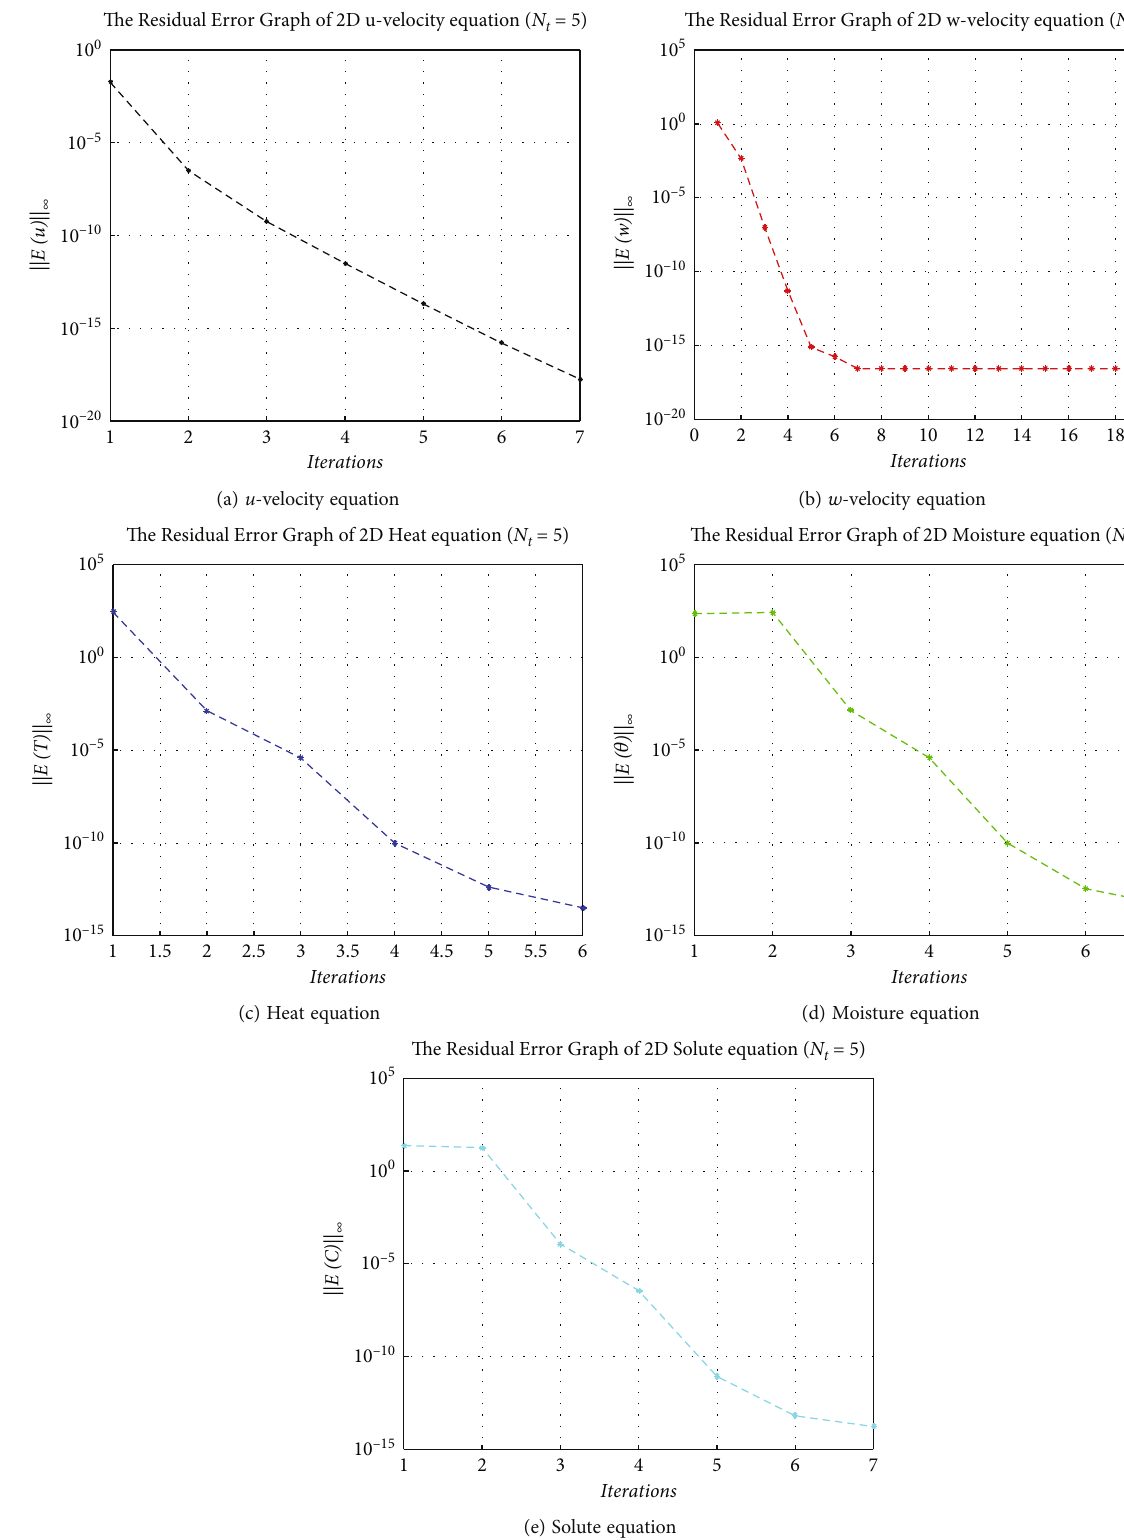
Figure 4: Error norms at di ff erent iteration points of the model, for N